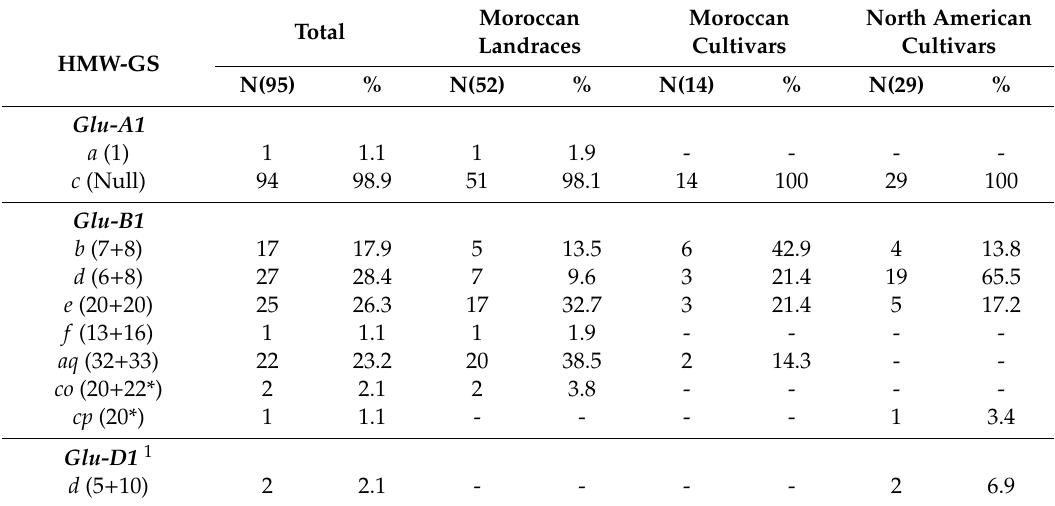
Table 1. Allelic frequency for each locus of HMW-GS in the durum materials analyzed.